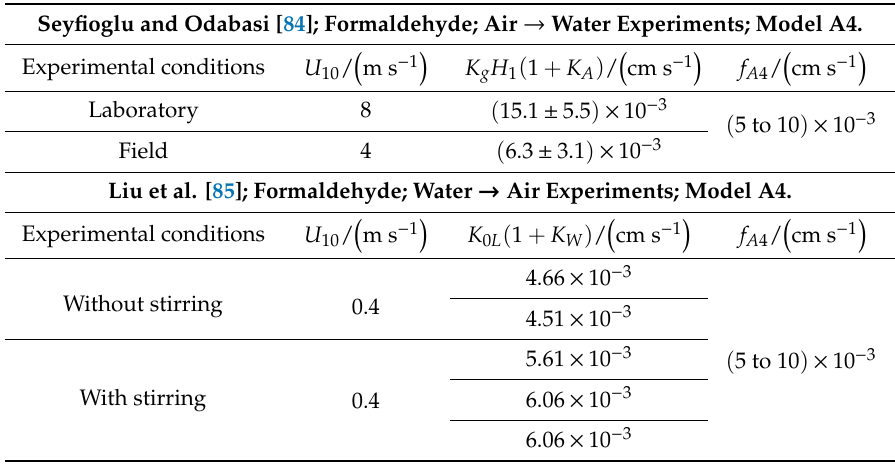
Table 8. Comparison with